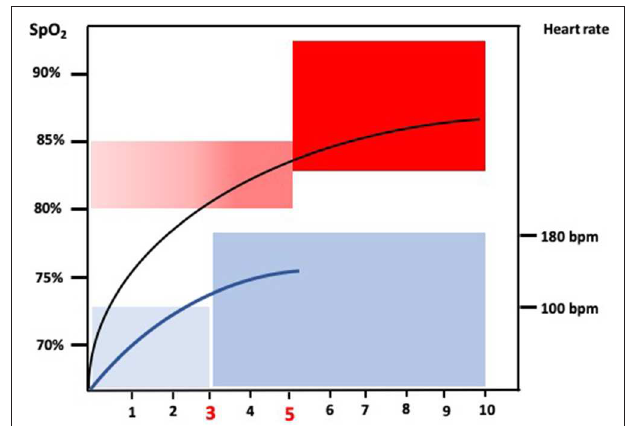
FIGURE 1 | The figure depicts the recommended arterial oxygen saturation ranges based on preductal pulse oximetry measurements for newborn infants in the first 10min after birth based on Dawson et al. ( 12). It also shows the recommended heart rate recommended ranges expressed in beats per minute based on Dawson et al. (